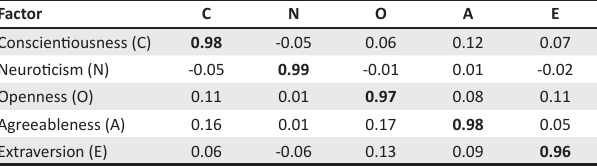
TABLE 1: Coefficients of congruence of Basic Traits Inventory factors for younger and older adolescents. Factor